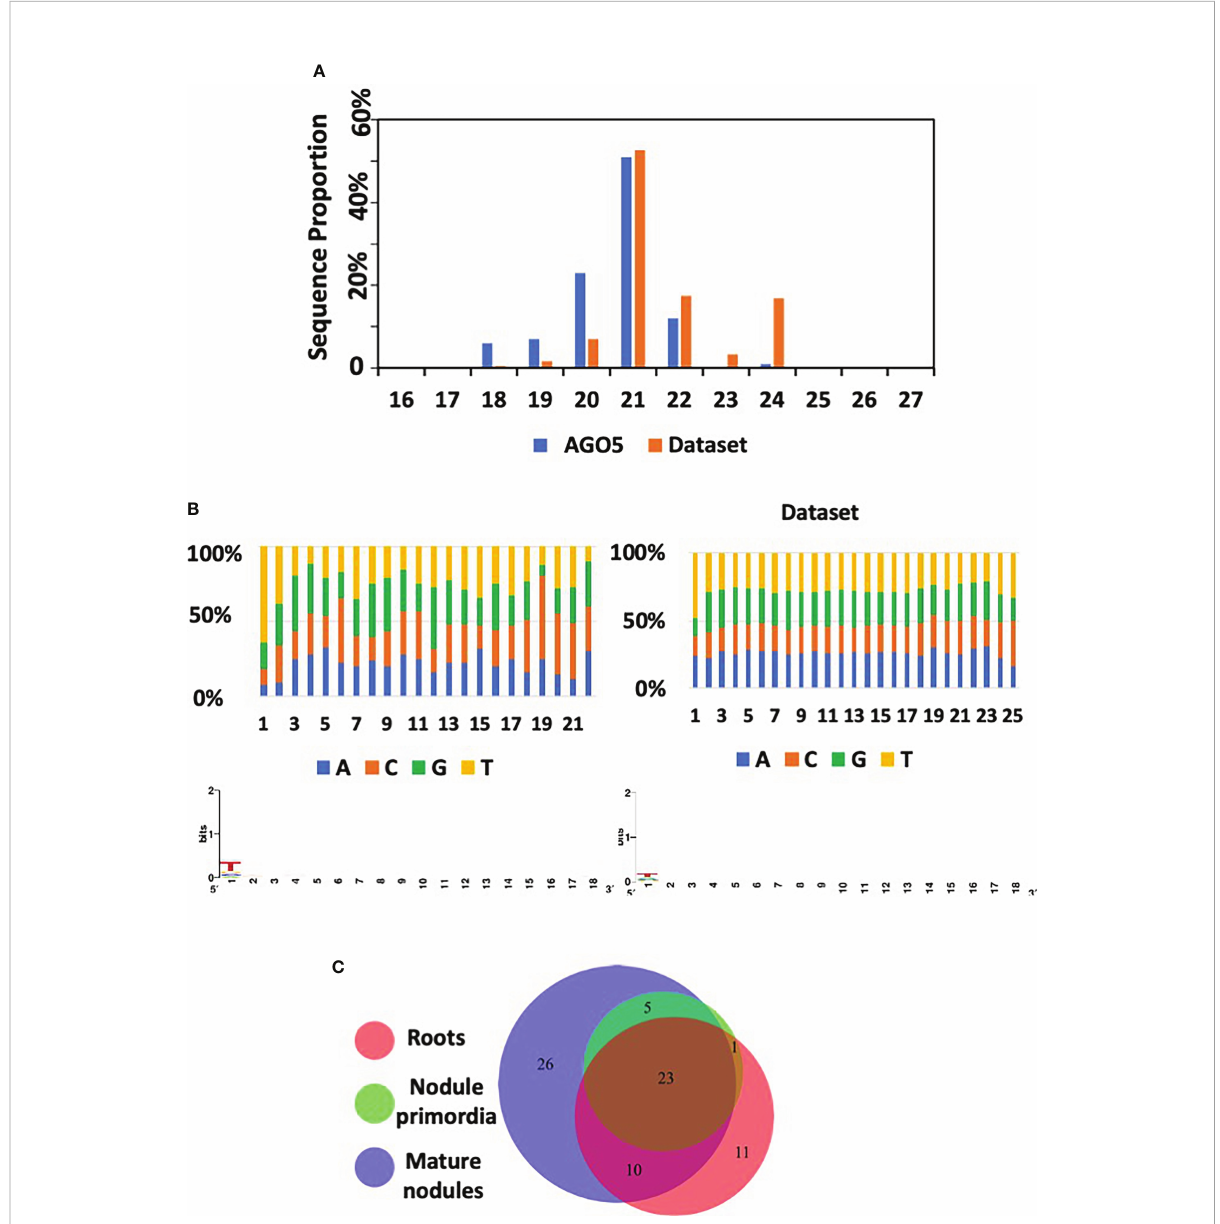
FIGURE 6 AGO5 sRNA cargo dynamically changes through the nodule development. (A) Length distribution of mapped sRNA reads isolated from AGO5 and the corresponding starting dataset. Starting dataset refers to the set of small RNA sequences used as reference for annotation of the sequencing results. (B) Read nucleotide distribution and 5 ’ bias of AGO5-associated sRNAs. (C) Number of sRNA associated in AGO5 from uninoculated roots, roots bearing nodule primordia, and mature